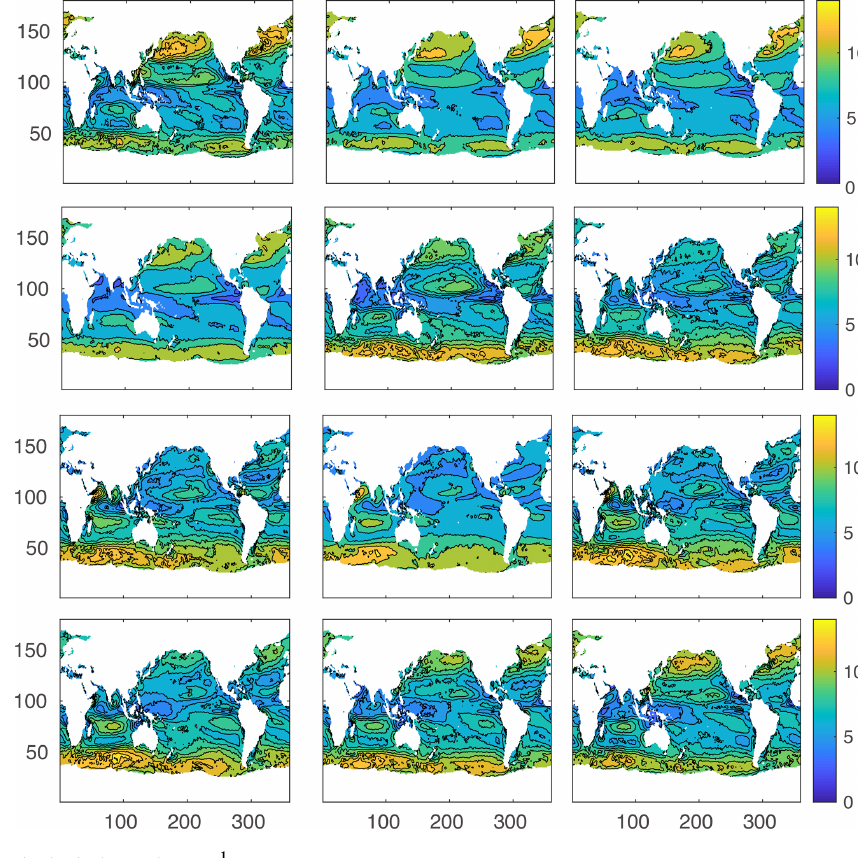
Figure A2. Climatological wind speed (ms − 1